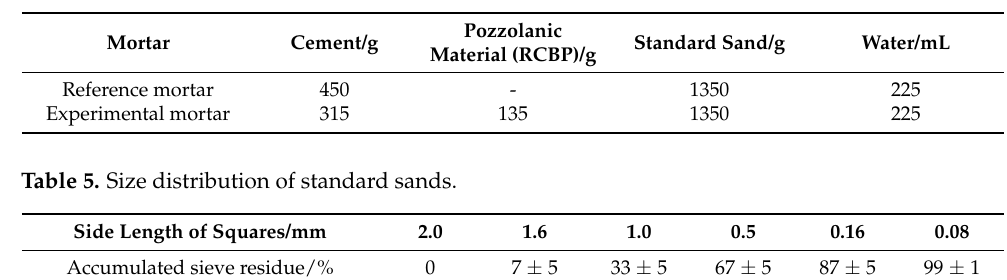
Table 4. Mix. proportion of experimental and reference mortars used in the pozzolanic activity test.